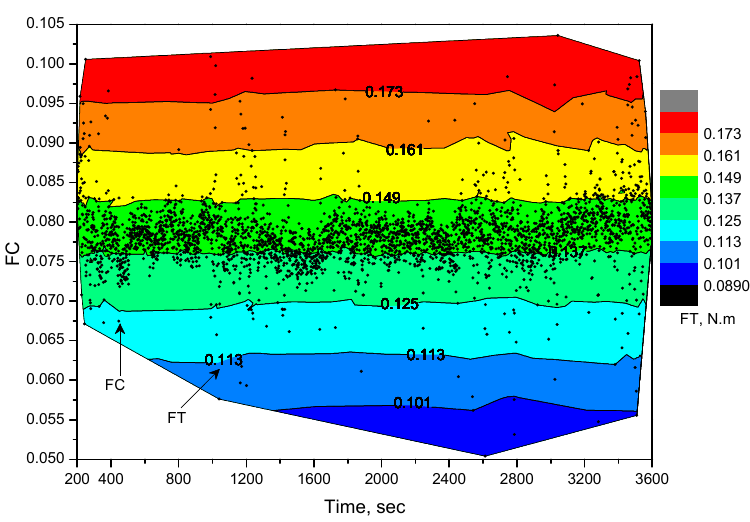
Figure 6. Correlation of FT and FC at steady state conditions for AvBn_Pa mixture blend.